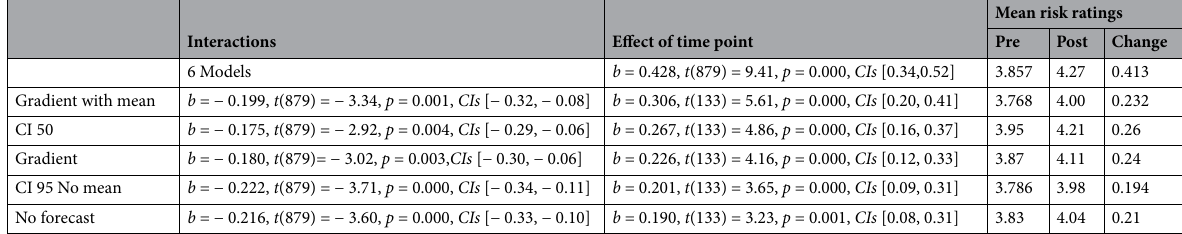
Table 2. Interactions between each visualization type and 6 Models, along with the effects of time point when models were computed for each visualization type (ordered by the size of the time-point main